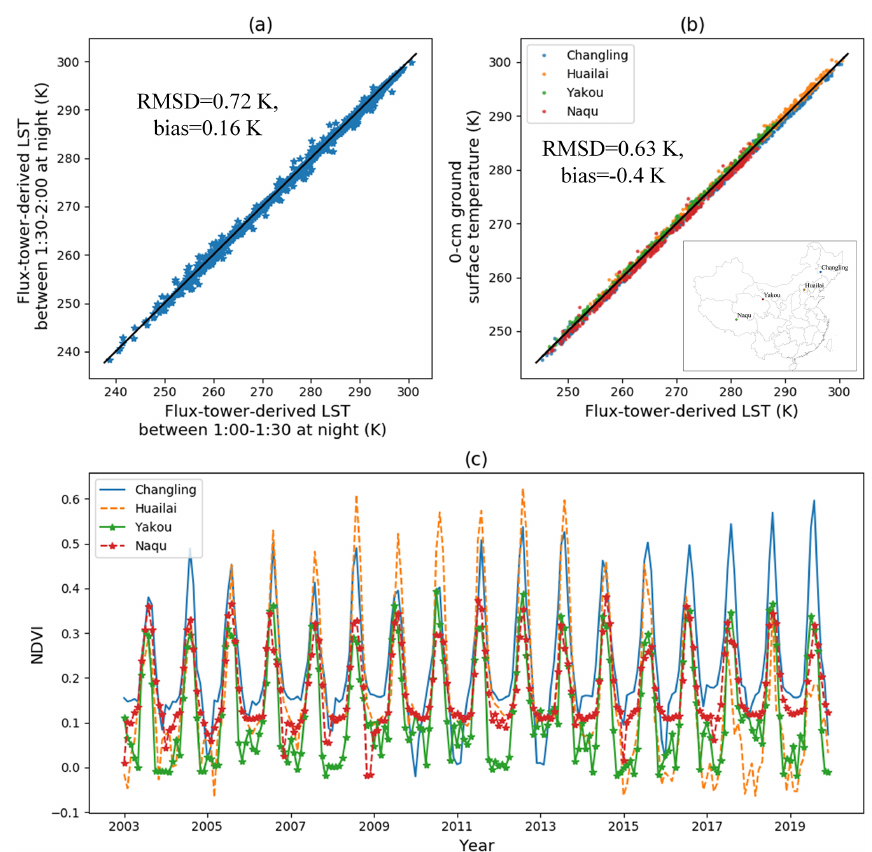
Figure C1. (a) Comparison of LST between 01:00–01:30 and 01:30–02:00LT for the four selected flux towers. (b) Comparison of flux- tower-derived LST averaged for 01:00–02:00LT at the four towers and corresponding nighttime 0cm ground temperature at proximal mete- orological stations. The inset map shows the location of the four flux towers. (c) Monthly NDVI time series for 1km pixels containing each of the four flux